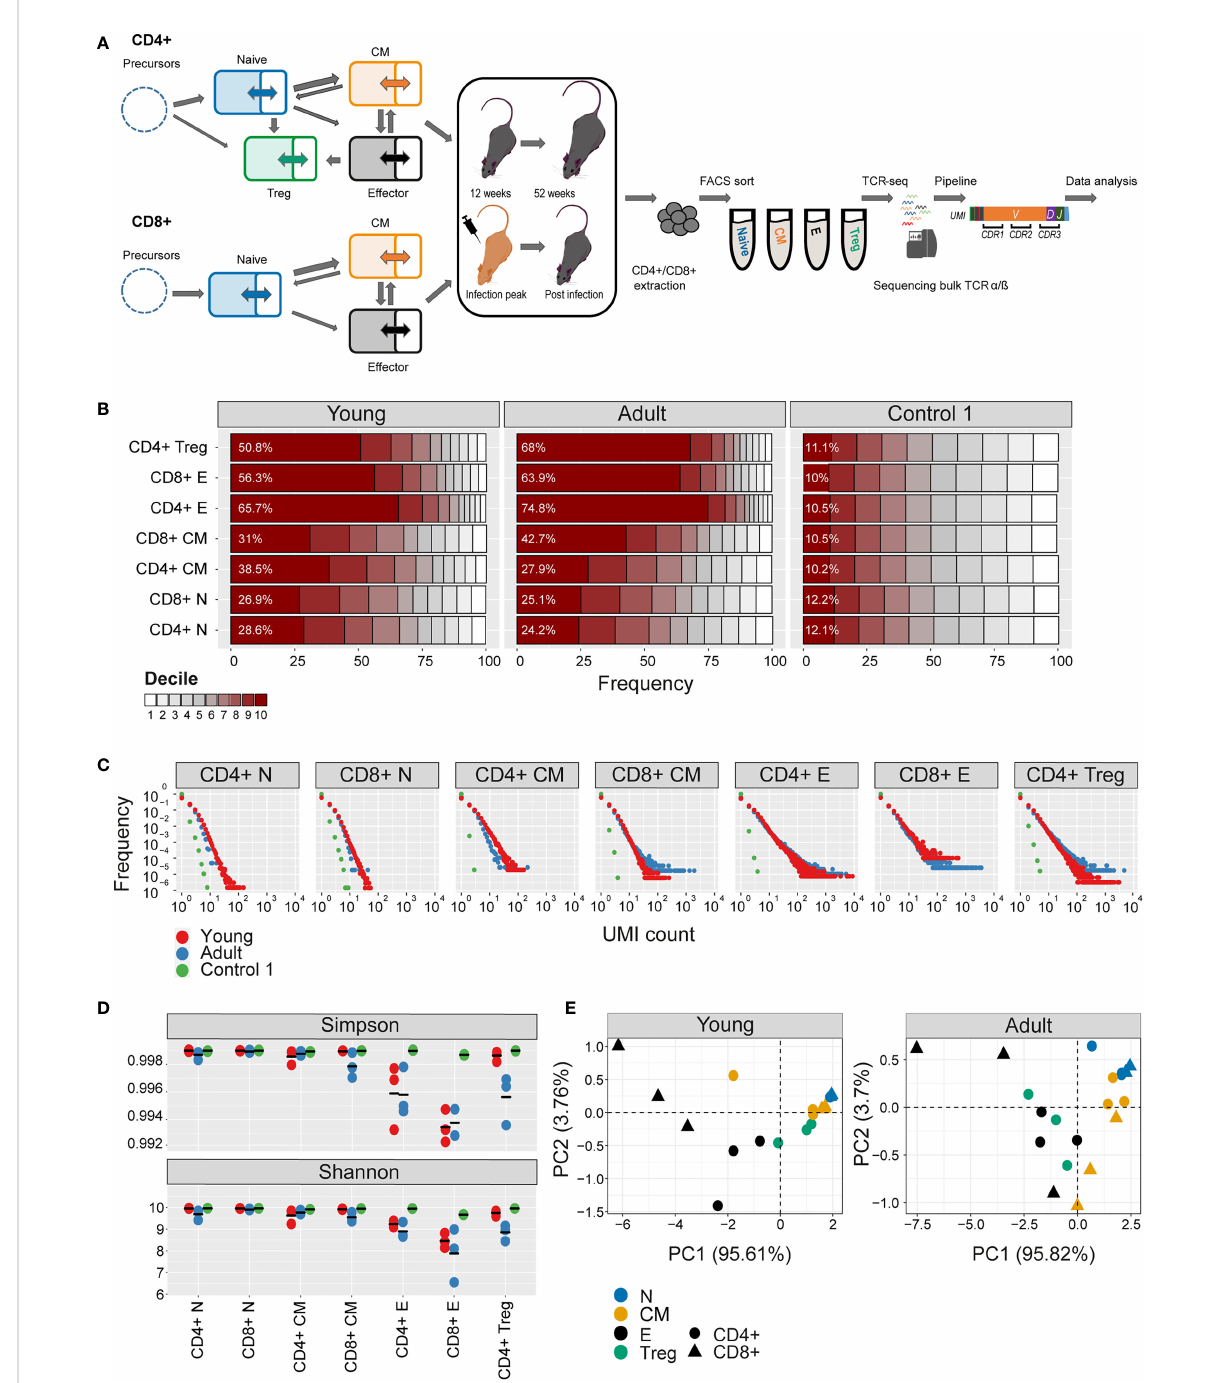
FIGURE 1 Clonal expansion and diversity of the TCR b repertoire in different subsets of young and adult mice. (A) Summary of T cell compartments and pipeline for cell isolation and TCR repertoire sequencing and analysis. (B) The TCRs in each repertoire were ranked according to frequency, and the proportion within each decile is illustrated (low abundance sequences in white, ranging to high abundance sequences in dark red). The percentage of the distribution represented by the top decile is shown in white text. (C) The sequence abundance distribution in each compartment. The plots show the proportion of the repertoire (y-axis) made up of TCR sequences observed once, twice, etc. (x-axis). Repertoires from young mice are shown with red dots, repertoires from older mice in blue dots, and synthetic repertoires in green. (D) Simpson and Shannon scores for subsampled repertoires of equal size (1000 CDR3NTs) from each compartment and mouse. Colors same as panel (C) Mean is shown as black lines (n=3). (E) PCA of the Renyi diversities of order 0, 0.25, 0.5, 1, 2,